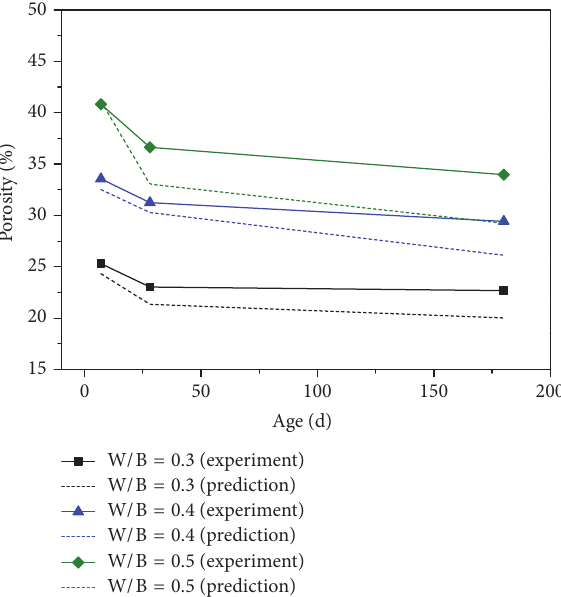
Figure 13: The predicted and measured values of porosity of cement-fly ash